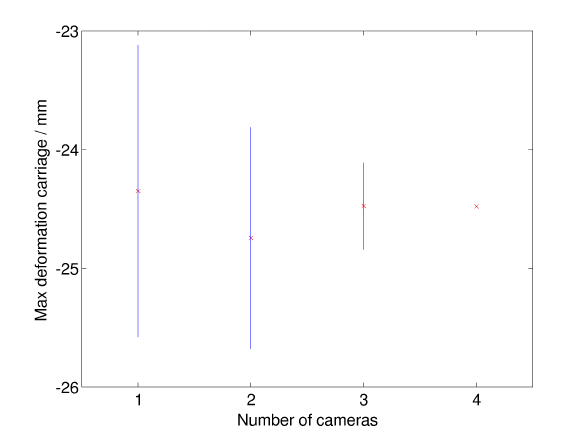
Figure 6: Deformation in the middle of the carriage ± sample standard deviation as a function of the number of cameras.